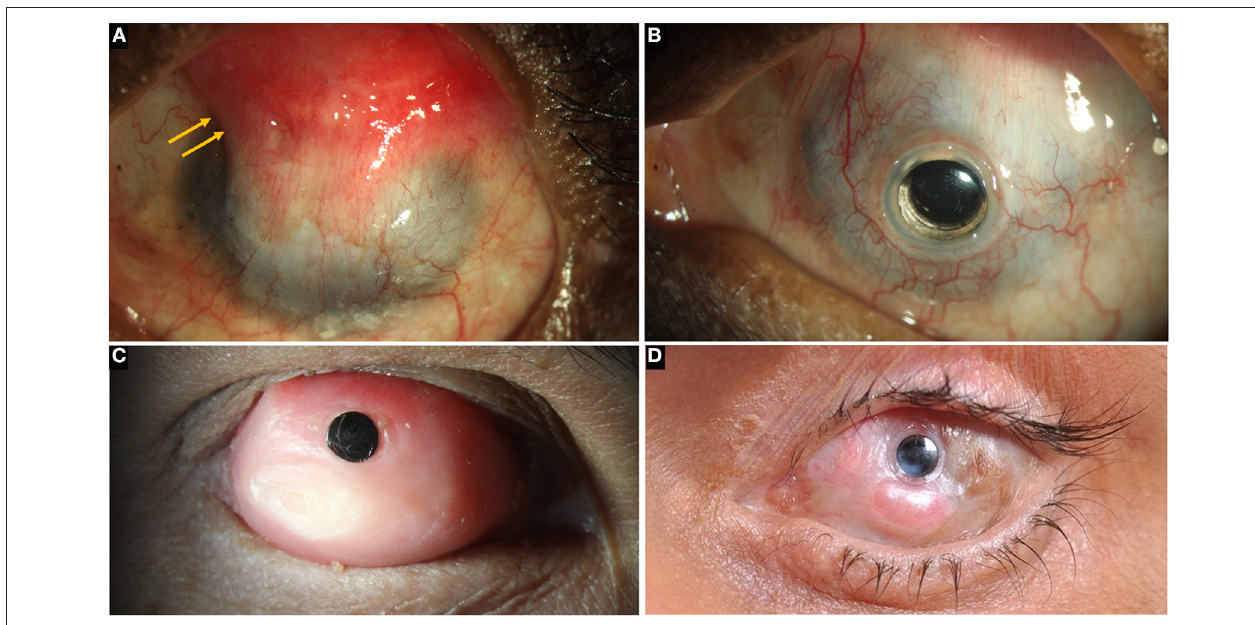
FIGURE 7 | (A) Left eye in a case of bilateral total limbal stem cell deficiency (LSCD) with a wet surface due to Stevens-Johnson syndrome (SJS). A superior conjunctival hooding (yellow arrows) was carried out previously for microbial keratitis with a corneal perforation. (B) A Boston keratoprosthesis in the same eye. (C) Modified osteo-odontokeratoprosthesis in an eye with total LSCD and a dry ocular surface. (D) LVP KPro in an eye with SJS.